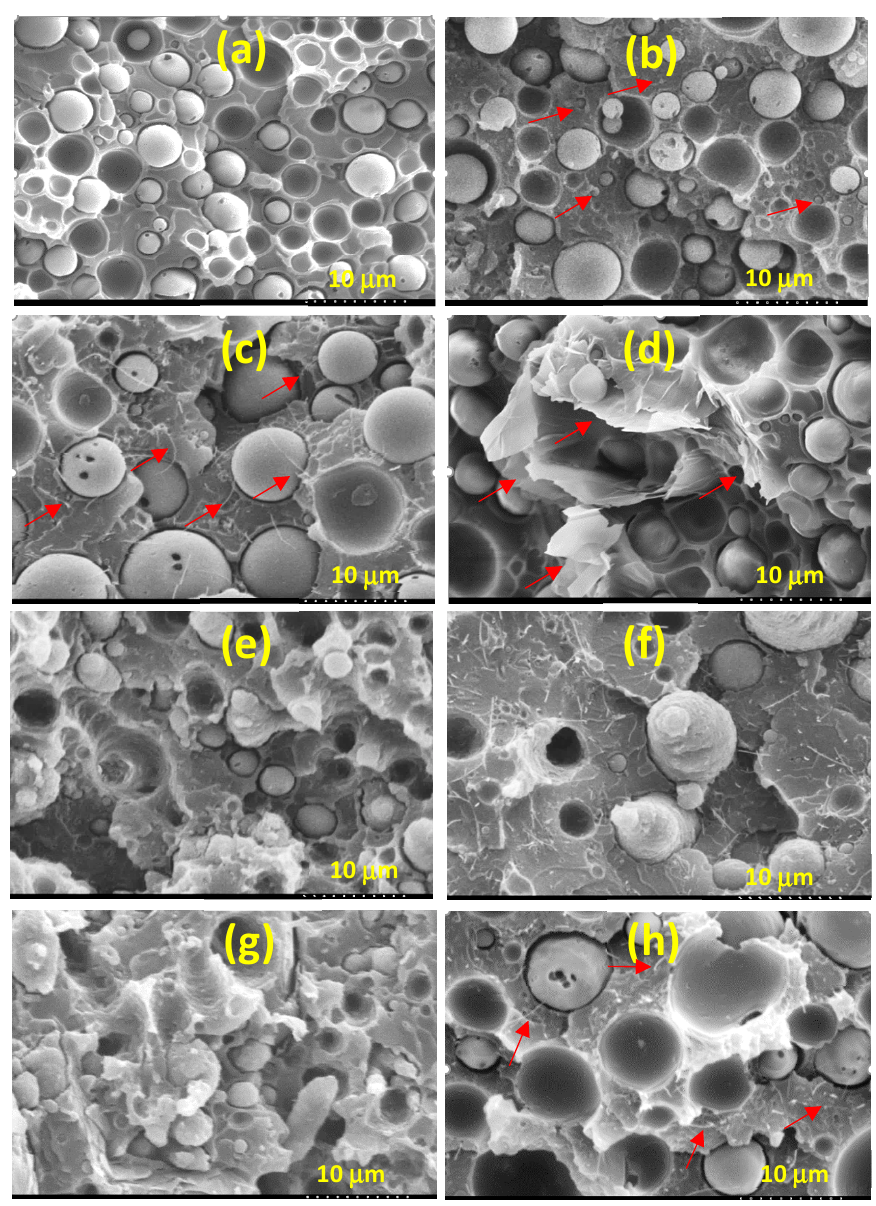
Figure 1. SEM images of: ( a ) CF (4.3 μ m), ( b ) CF-B (6.9 μ m), ( c ) CF-T (7.2 μ m), ( d ) CF-P (6.8 μ m), ( e ) CF-BA (5.5 μ m), ( f ) CF-TA (5.8 μ m), ( g ) CF-PA (5.6 μ m), and ( h ) CF-TB (7.6 μ m).